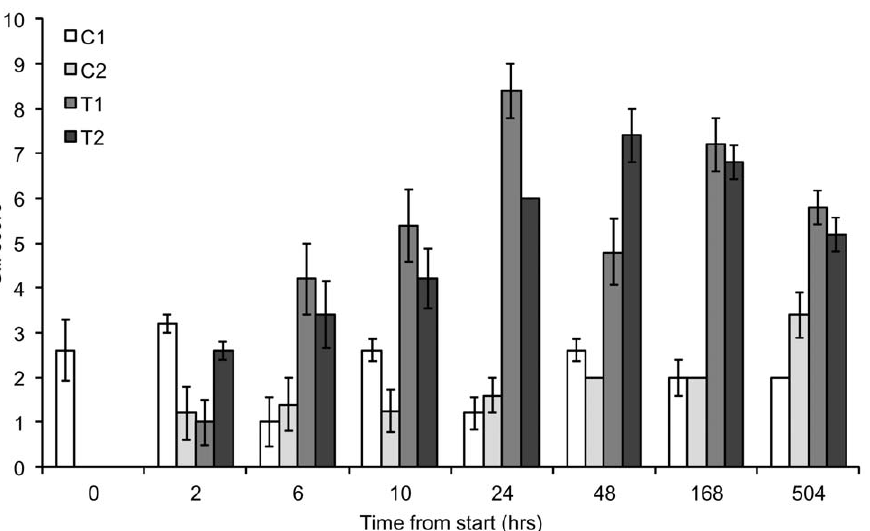
Figure 2. Gill scores of control and test groups with time from the start of the experiment. Gill scores for Control group 1 (C1), Control group 2 (C2), Test group 1 (T1) and Test group 2 (T2). All values are means 6 1 S.E.